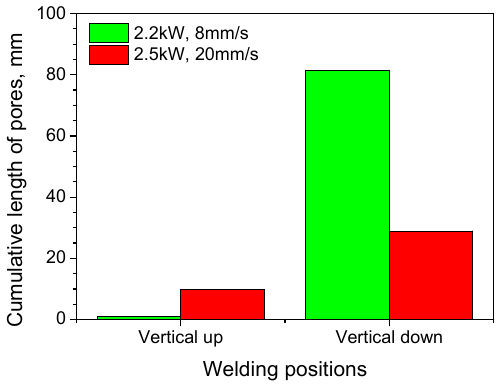
Figure 6. Cumulative lengths of pores under different welding conditions.